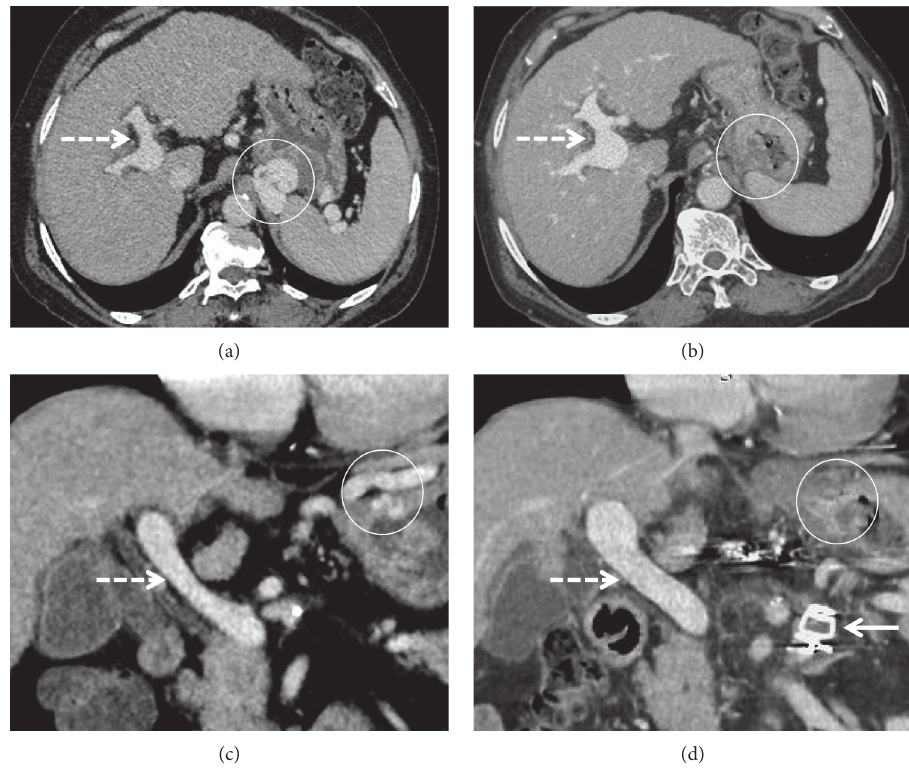
Figure 10: Fluoroscopic spot images depicting persistence of a splenorenal shunt (arrowhead in (a)) after placement of a TIPS stent (dashed arrow). The shunt was occluded by combined antegrade-retrograde accelerated trap obliteration technique using vascular plugs (solid arrows) and sclerosant